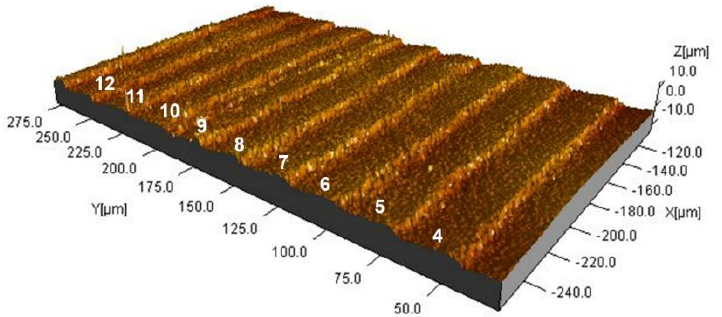
Figure 8. Corrected height map of region of interest of the QR code on the mortar insert. The height map was levelled by first-order polynomial in order to correct it for any tilting angle of the specimen. No other corrections were applied to the data underlying this figure. The numbers 4 through 12 refer to different ripples.